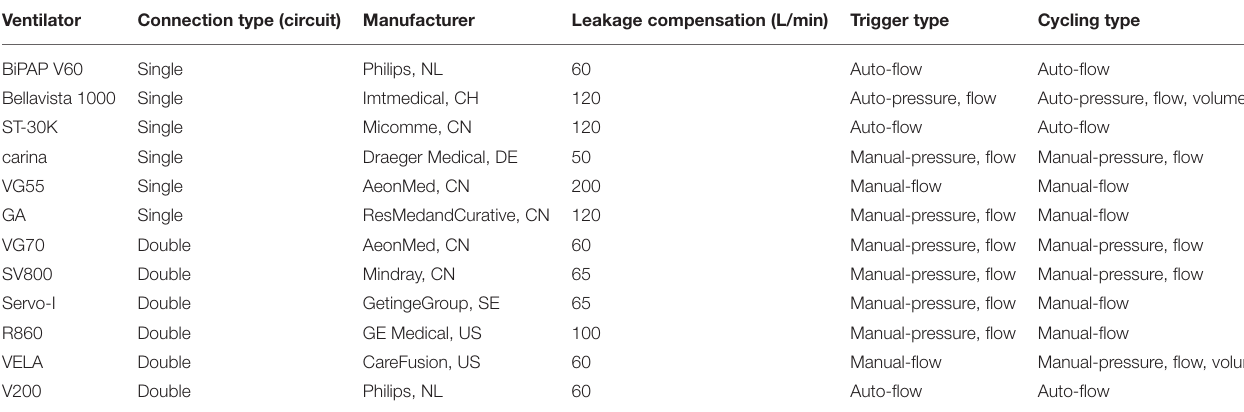
TABLE 1 | Summary of ventilators examined in the study.